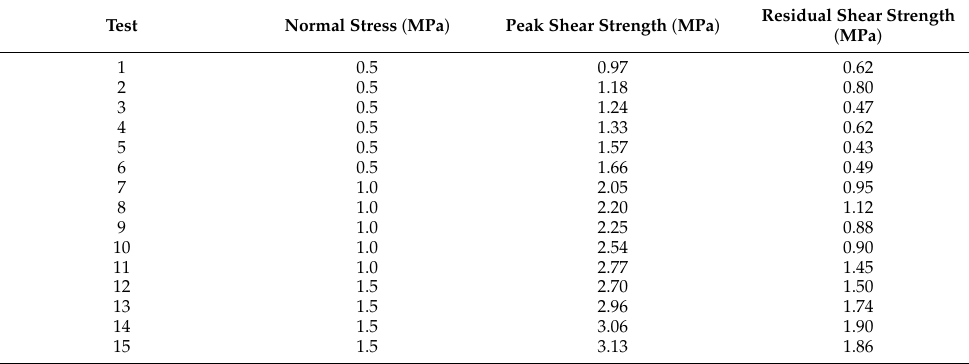
Table 4. Summary of the direct shear tests on natural granite